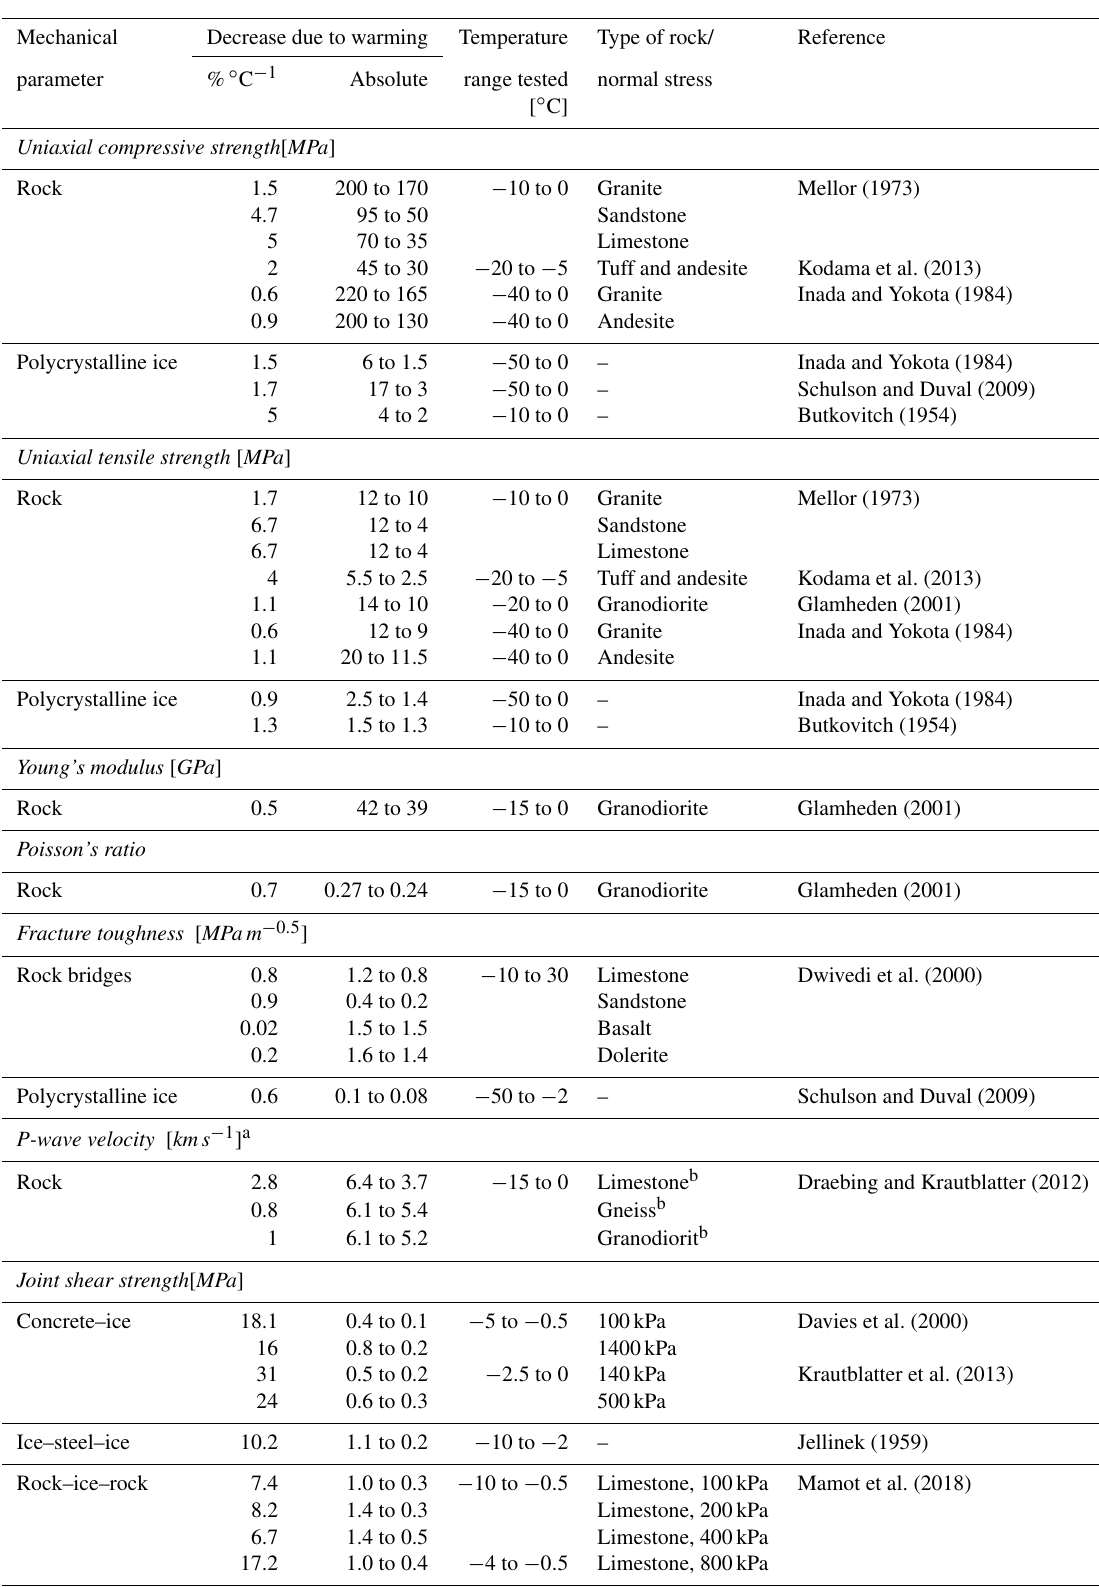
Table 1. A systematic survey of previous laboratory studies on the thaw-dependent strength reduction of mechanical properties of rock, rock joints and